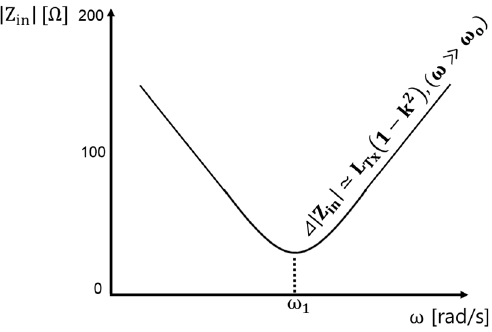
Figure 5. Schematic diagram of the input impedance according to the operating frequency.